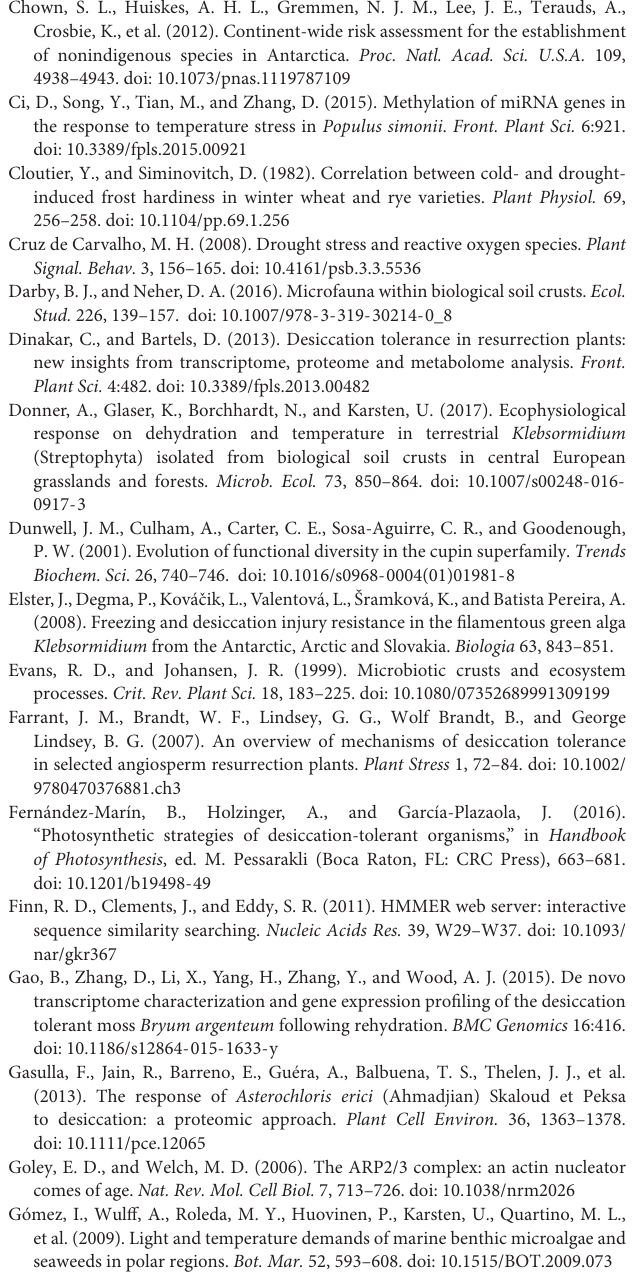
FIGURE S1 | KEGG map overview showing all the mapped annotated KO IDs for K. dissectum . FIGURE S2 | KEGG map overview showing all the mapped annotated KO IDs for K. flaccidum .